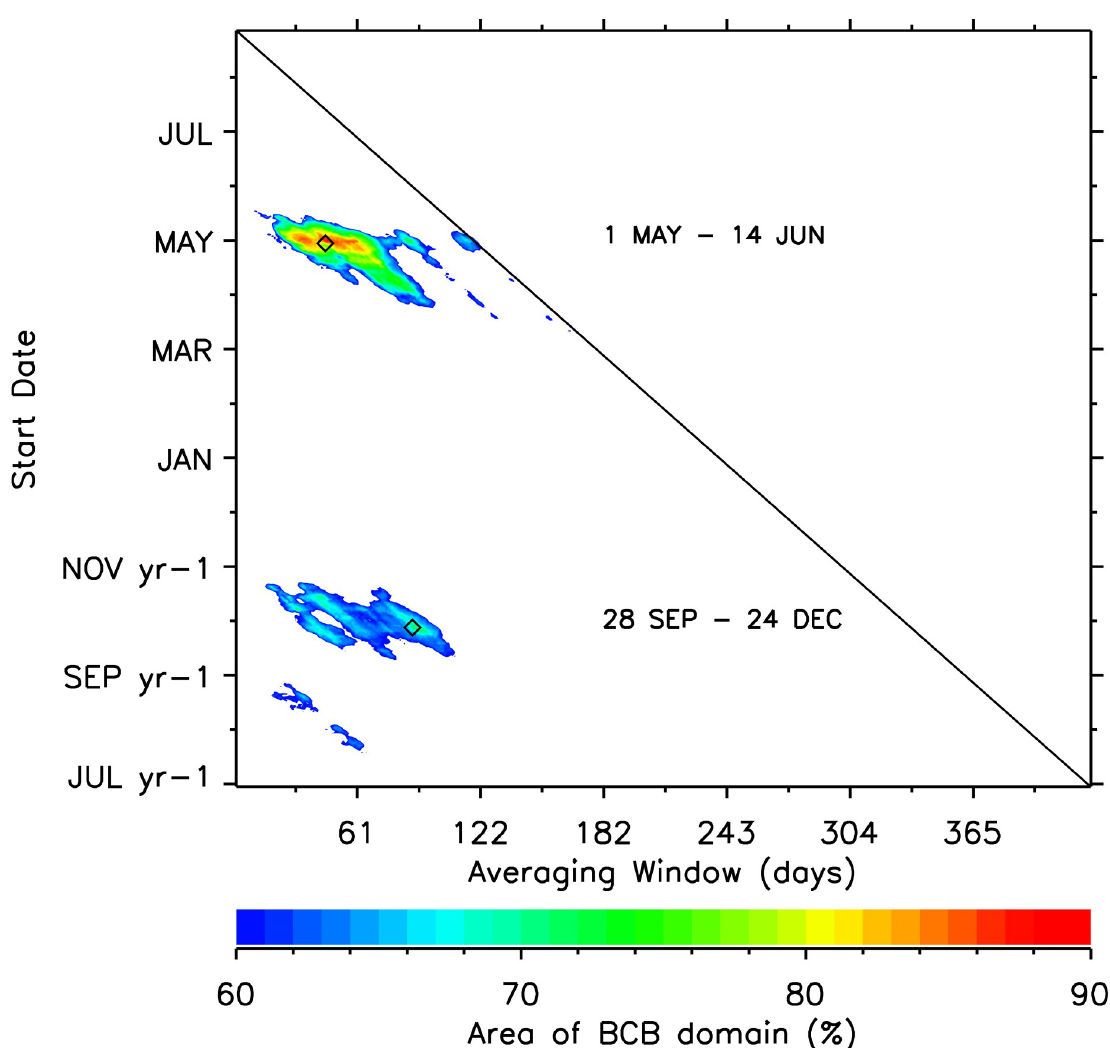
Fig 6. Percentage of the Bering-Chukchi-Beaufort (BCB) spatial domain with statistically significant correlations between averaged (U, V) winds and JAD fractions. Contours show % area with statistically significant correlations (r > 0.602, p < 0.05; 9 degrees of freedom, two-tailed test) over a range of start dates and averaging periods. The diamond symbols identify the averaging coordinates for seasonal maxima. No results were computed for averaging period and start date pairs lying above the diagonal line because averaging periods end after 31 August of survey